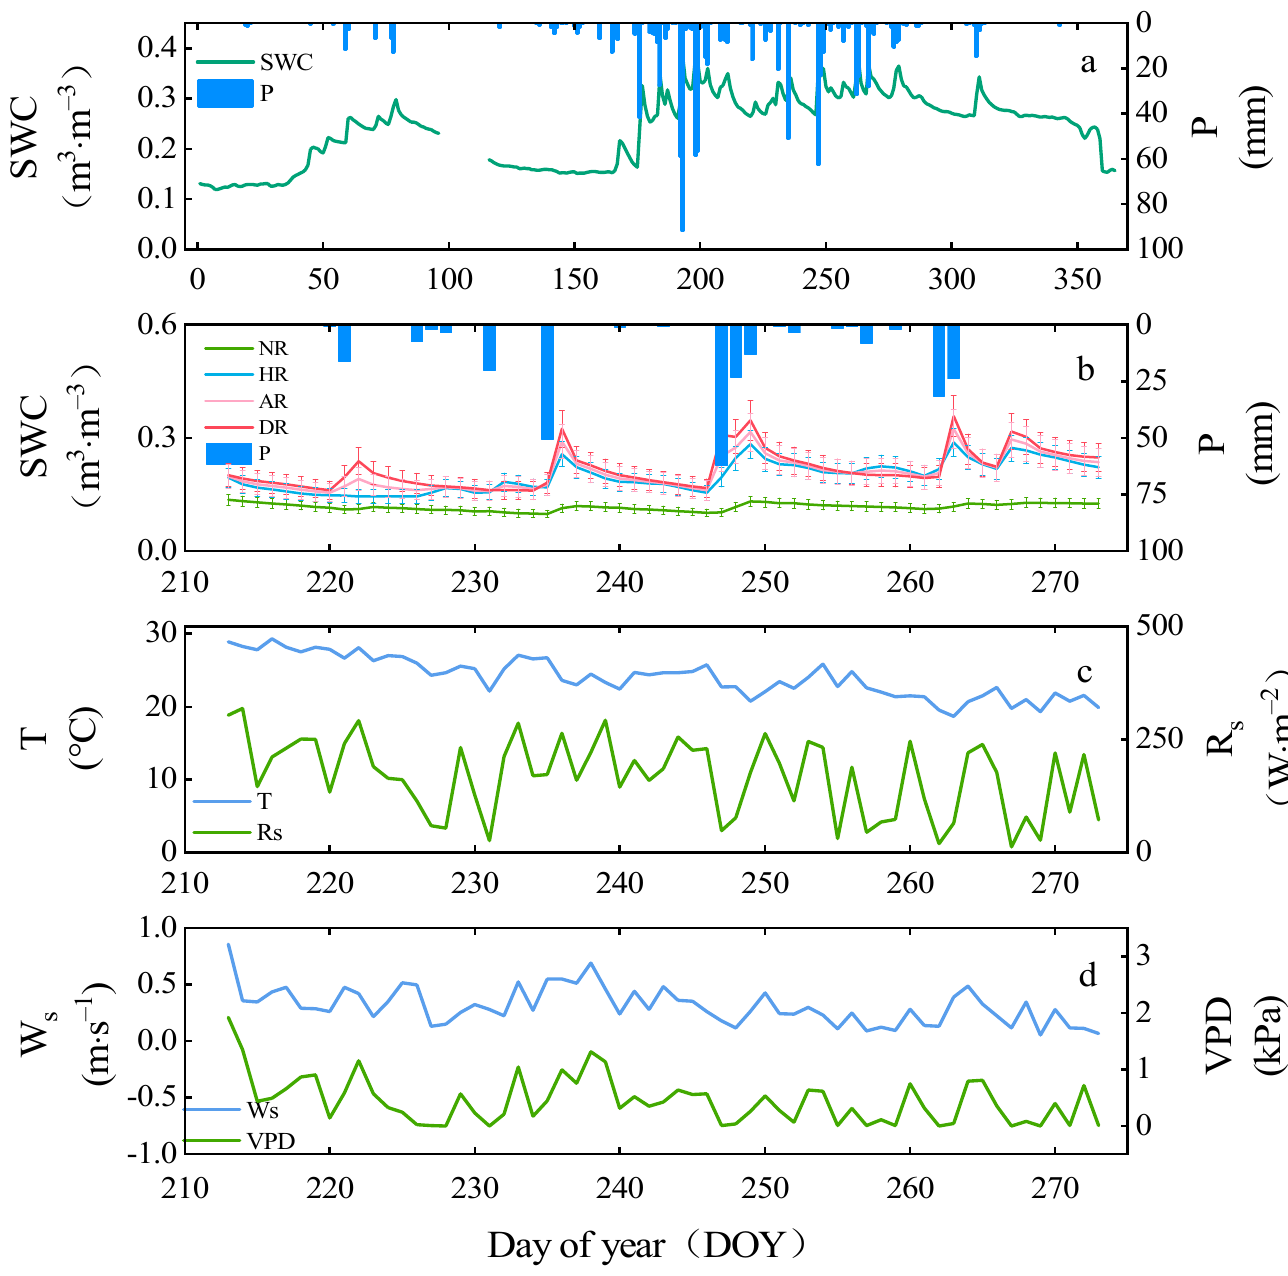
Figure 3. ( a ) Precipitation (P) and soil water content (SWC) in 2021; ( b ) precipitation (P) and soil water content (SWC) of four treatments in the rainy season (1 August–30 September) of 2021; ( c ) air temperature (T) and solar radiation (R S ) during the observation period; ( d ) wind speed (W S ) and vapor pressure deficit (VPD) during observation. The values of SWC are the means of measurement at soil depths of 10, 30, 50, 70, and 90 cm over the study site. Note: data from 8 April to 25 April is missing for 2021.